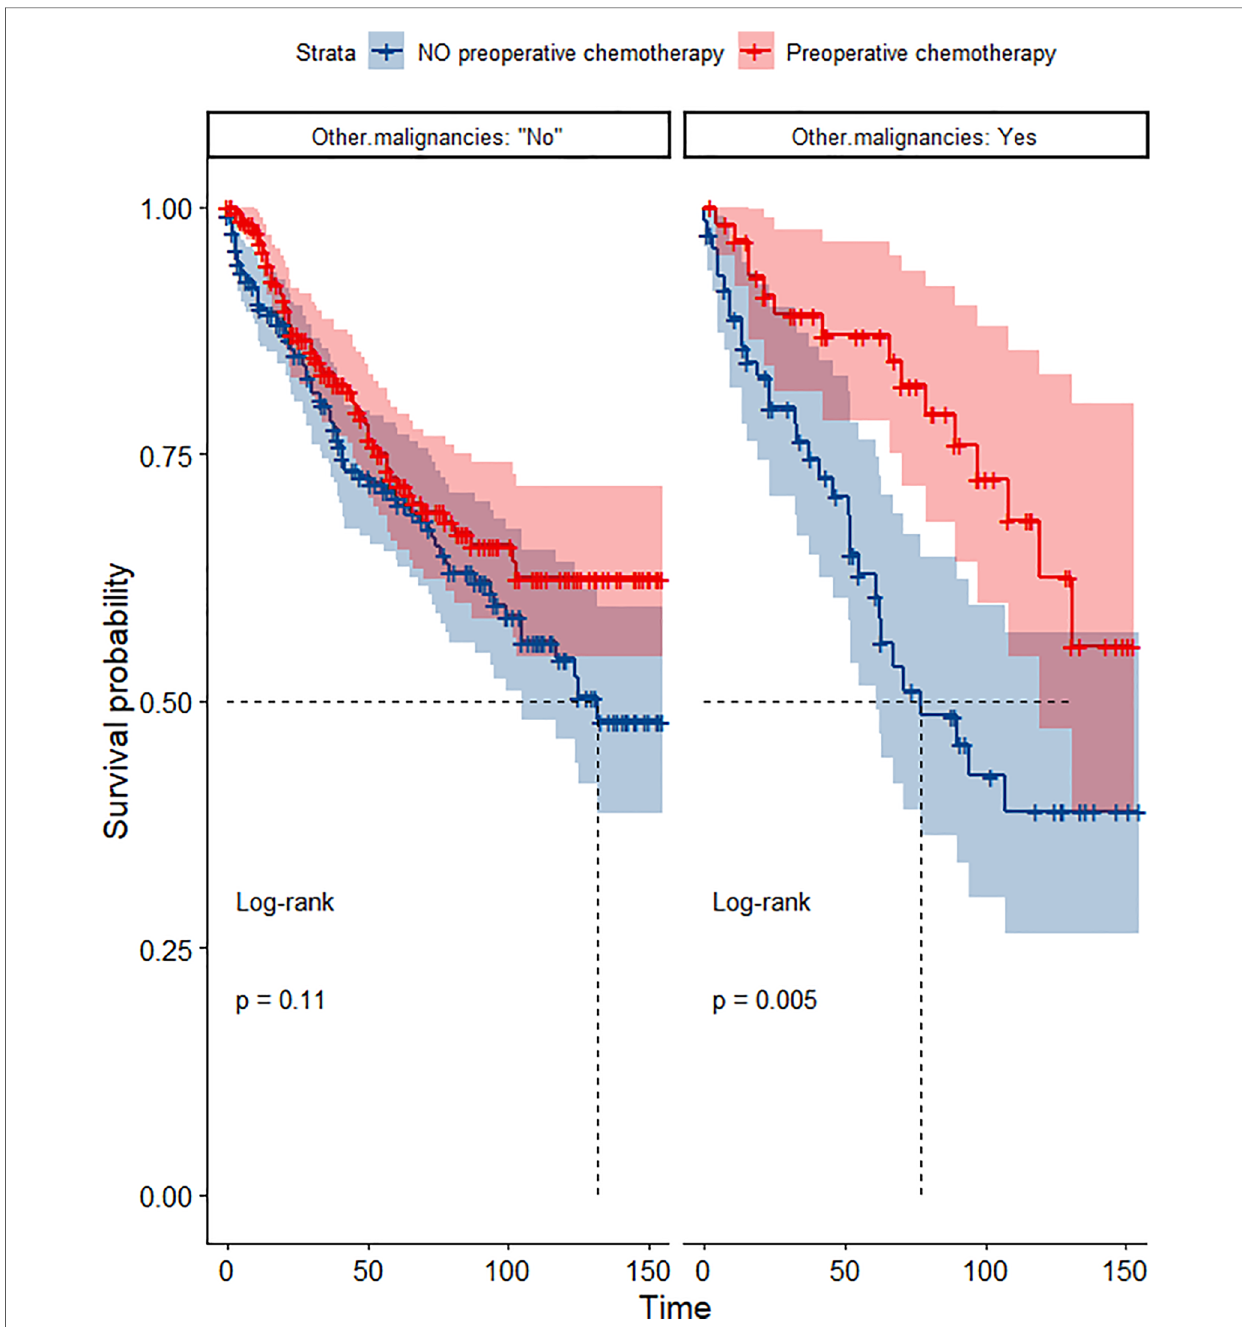
FIGURE 13 Survival curves of OS in the POCT and no POCT groups in patients with or without other malignancies undergoing surgery for TETs after propensity